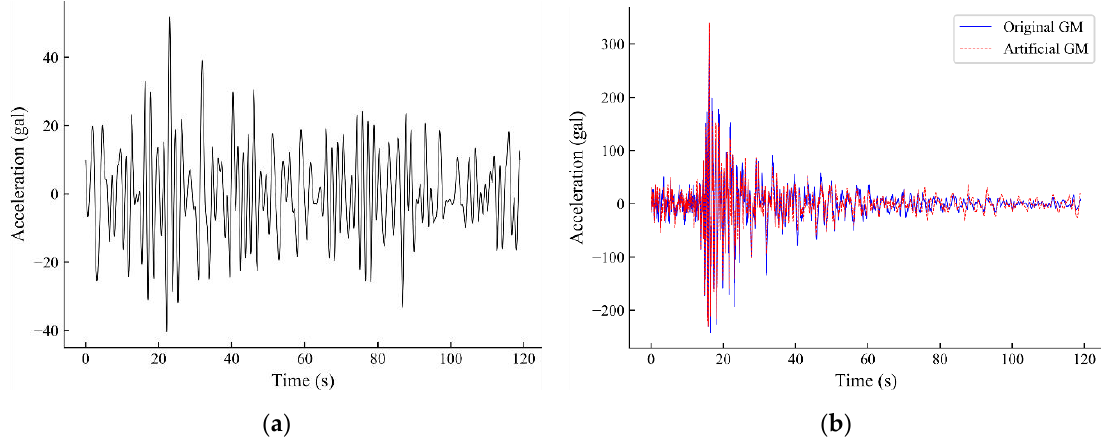
Figure 6. A case of artificial ground motion simulation by Stochastic Method: ( a ) Random disturbance; ( b ) Original and artificial time series.